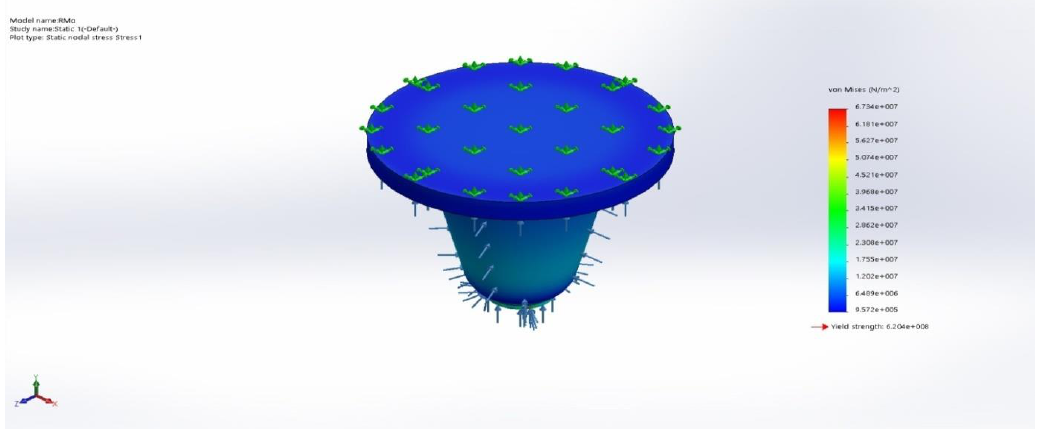
Fig.10. Stress distribution on male mould.